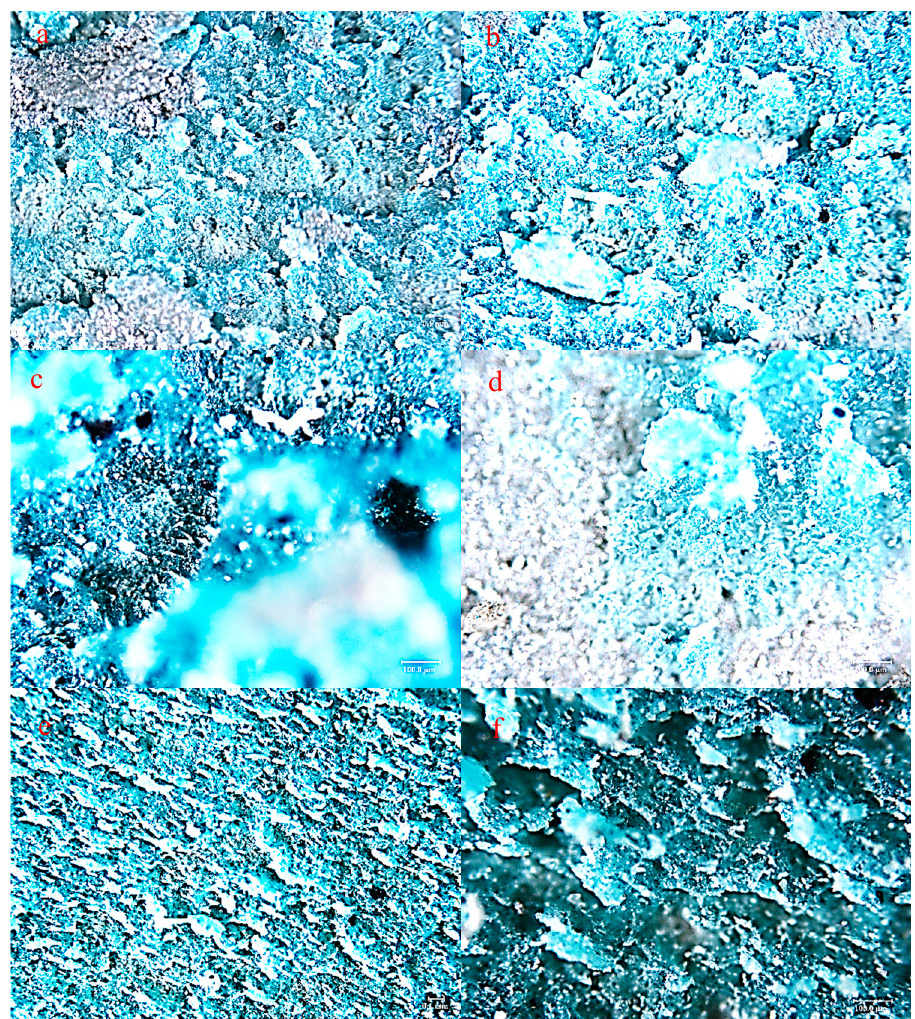
Figure 27. Adhesive 4 lap shear failure surfaces at di ff erent extension rates. ( a , b ) 4 × magnification at 25 mm / min; ( c , d ) 10 × magnification at 25 mm / min; ( e ) 4 × magnification at 500 mm / min; ( f ) 10 × magnification at 500 mm /